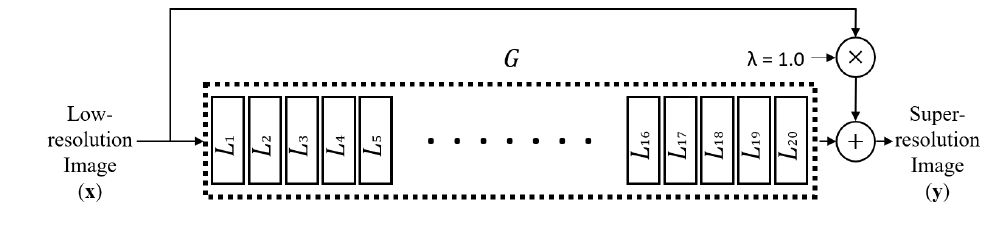
Figure 1. VDSR network consisting of one layer group with one skip connection ( l = 20, λ =